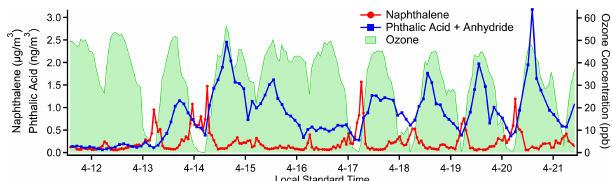
Figure 8. Concentration timelines for naphthalene, a primary emis- sion from vehicle exhaust measured on cTAG’s I/VOC chan- nel, and the sum of phthalic anhydride and phthalic acid, sec- ondary photooxidation products of naphthalene detected on cTAG’s SVOC channel. Another secondary compound, ozone, measured at a nearby Bay Area Air Quality Management District monitoring site, provides an independent indication of photochemical